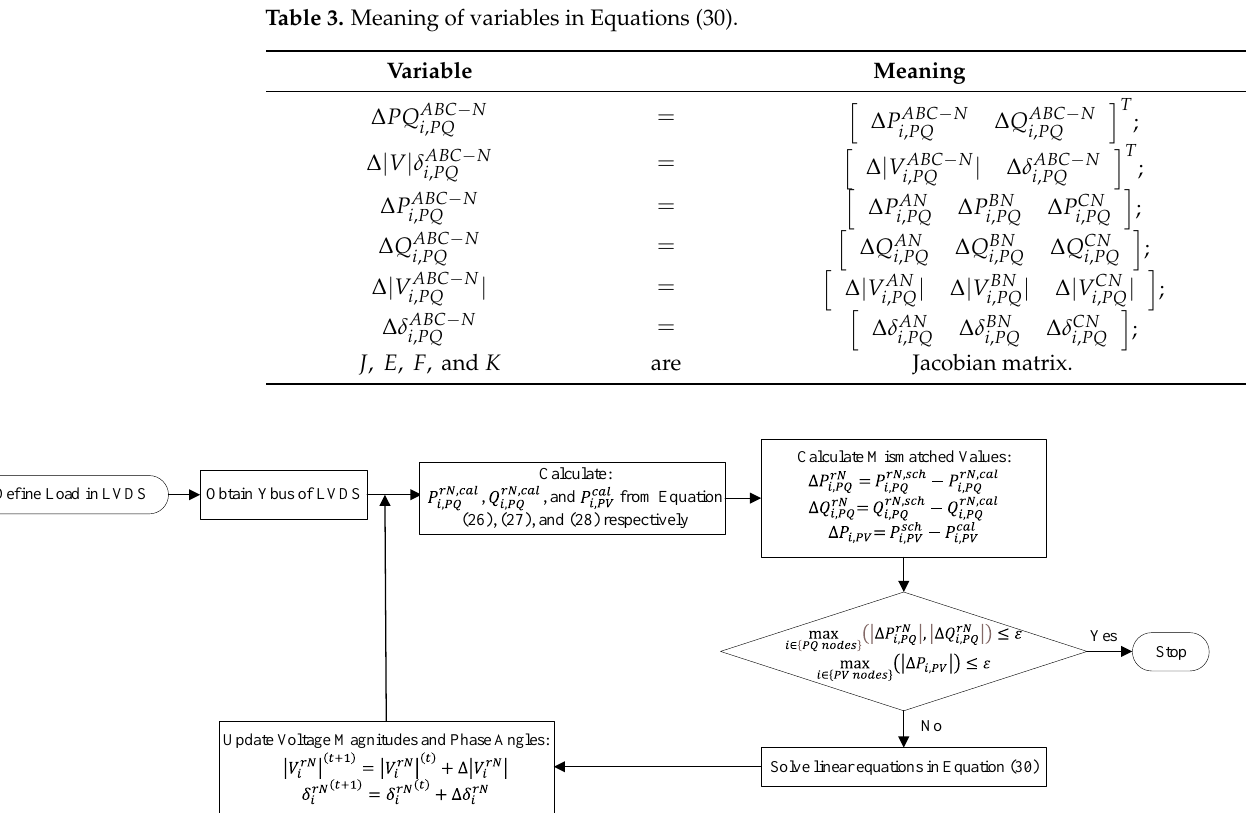
Figure 6. The flowchart of solving the improved LF equations by the NR method.